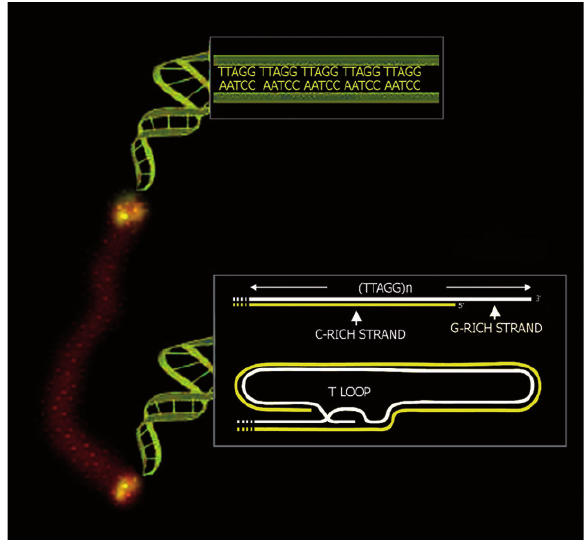
Figure 1 The most common telomere structure in insects consists repeat at each chromosome end, with telomeric DNA of a (TTAGG) n forming a particular folding (T loop) to stabilize and protect the chro- mosomal